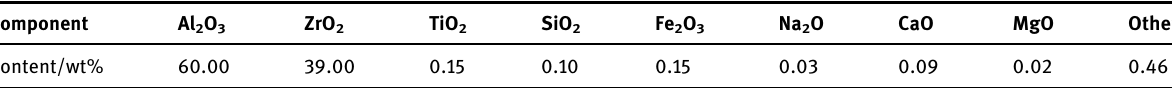
Table 3: Chemical components of ZTA particles ( wt% ) Component